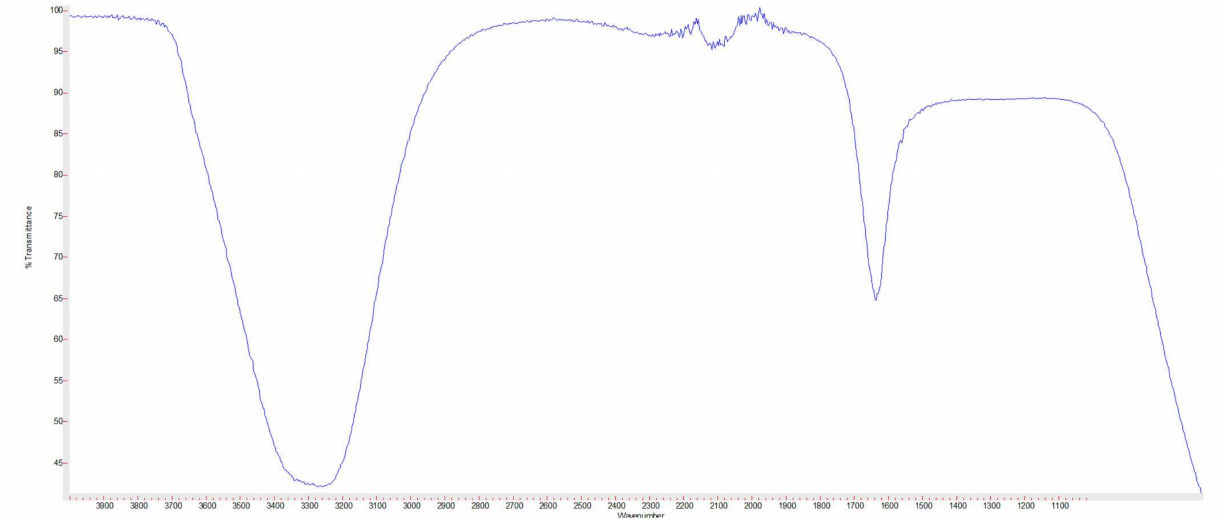
Figure 3. Fourier-Transform infrared (FTIR) spectrum of